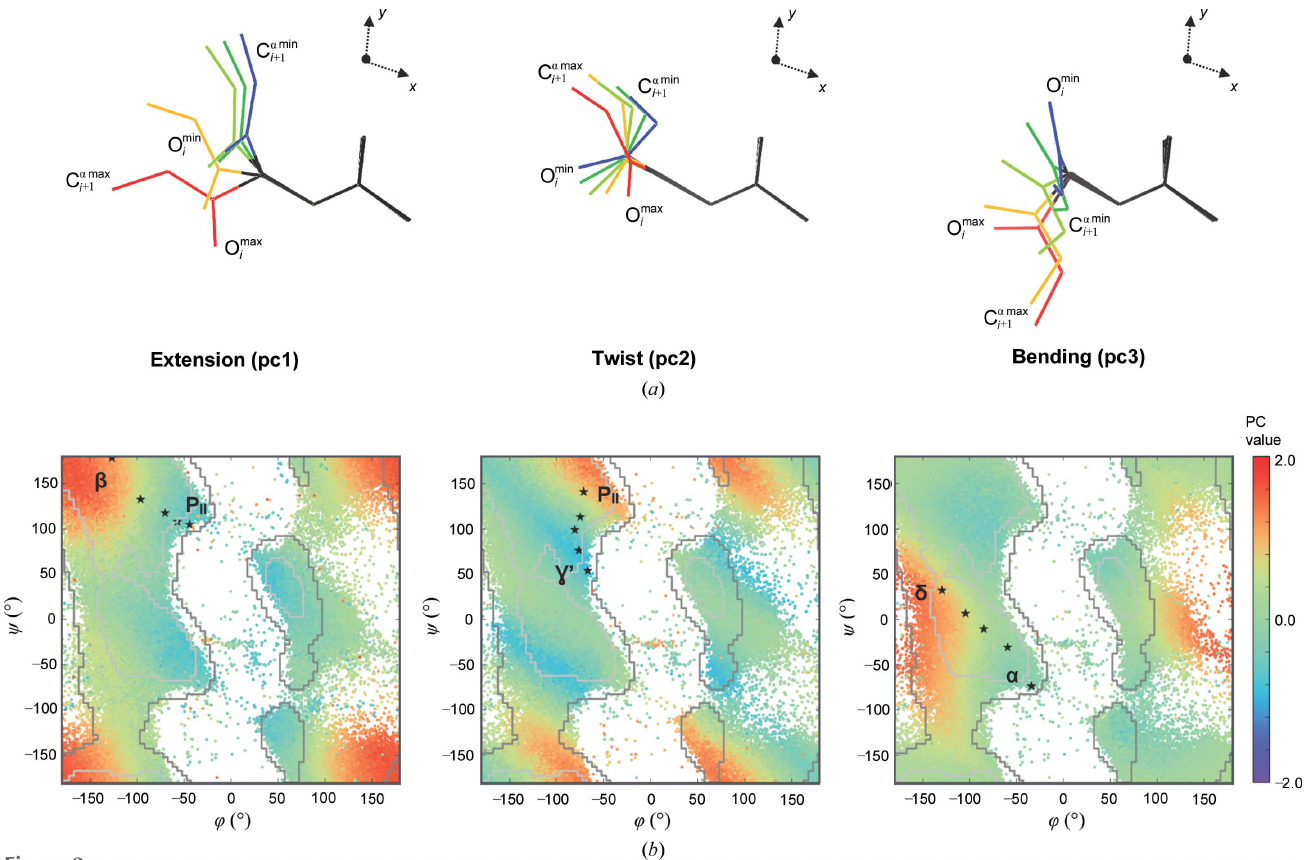
Figure 2 Conformations of a dipeptide unit described by the three DipSpace axes. ( a ) Representative dipeptide units from the negative subspace with their two DipSpace coordinates fixed while varying the third coordinate between its minimum (blue) and maximum (red) values, as described in x 2. ( b ) Exemplary projection of the DipSpace on the Ramachandran plot with its general limits (Lovell et al. , 2003) shown. Stars mark the path through the conformations shown in ( a ). The nomenclature follows that of Hollingsworth & Karplus (2010): (cid:8) , (cid:8) -strands; (cid:2) , (cid:2) -helices, (cid:9) ’, (cid:9) ’-turns; (cid:10) , bridge region, several types of turns; P II , P II